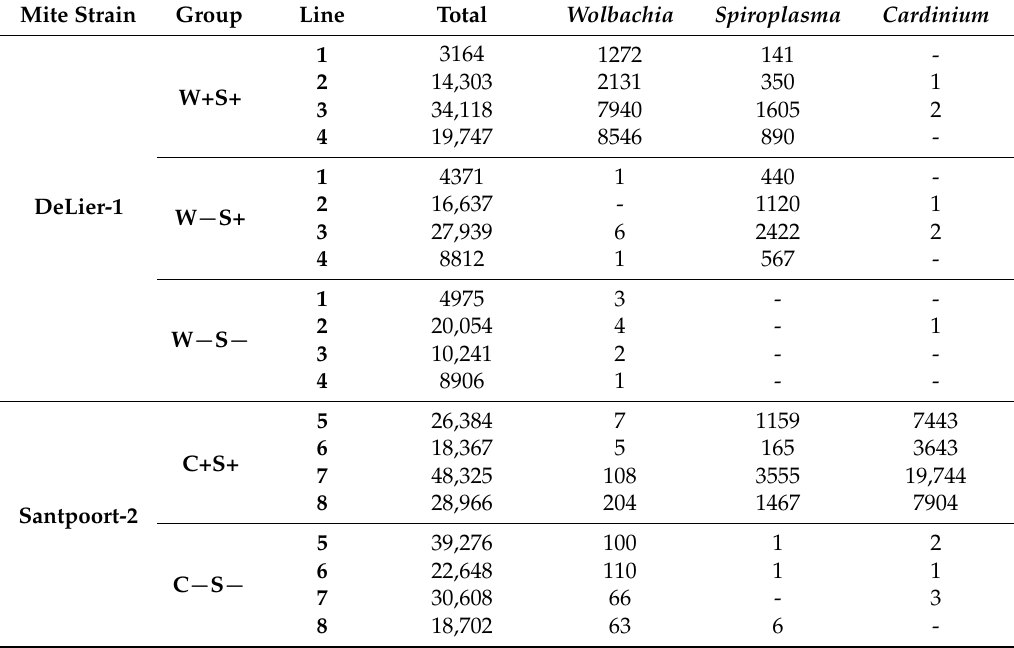
Table 1. Antibiotics treatments of two strains of the spider mite T.etranychus urticae resulted in the (near) complete removal of their associated bacteria Wolbachia , Spiroplasma and/or Cardinium , as demonstrated by Illumina 16S rRNA amplicon-sequencing. The T. urticae DeLier-1 strain contained Wolbachia and Spiroplasma (W+S+) and tetracycline treatments either removed only Wolbachia or both bacteria, yielding the groups W − S+ and W − S − , respectively. The Santpoort-2 strain harboured Cardinium and Spiroplasma (C+S+), which were both removed by the tetracycline treatments, yielding the C − S − group. Each group is represented by four independent mite lines. We refer to one line in one group as a subline (e.g., line 1 in the W+S+ group). Note that mites from lines with the same number are “sister lines” which originate from the same untreated adult female. Shown are the overall total number of Illumina reads obtained per subline, as well as the total number of reads corresponding to all 11 Wolbachia operational taxonomic units (OTUs), all 3 Spiroplasma OTUs and the only Cardinium OTU identified. The 16S rRNA amplification was done with universal 341F and 785R primers, modified from [61], see Table